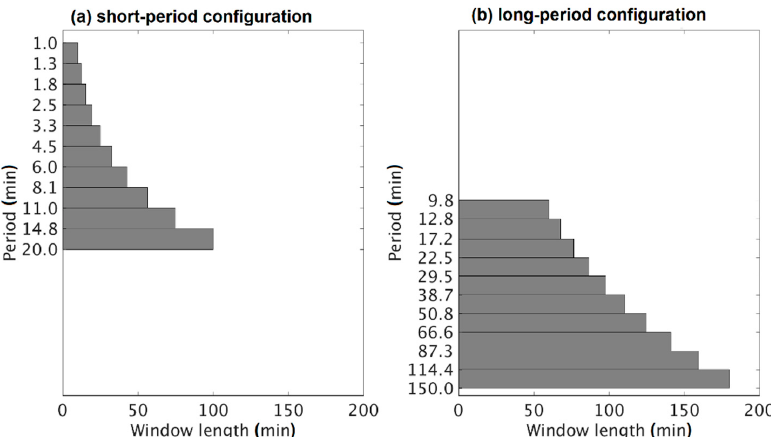
Figure 2. The panels show the different configurations used for running the Progressive Multi- Channel Correlation (PMCC) algorithm to detect gravity waves (GWs), ( a ) for frequencies corresponding to periods of 1 min to 20 min, including acoustic-GWs; whereas ( b ) focuses on GW detections of from 10 min to 150 min. In both cases, the consecutive time windows overlap. The time step is 10% of the window length. window